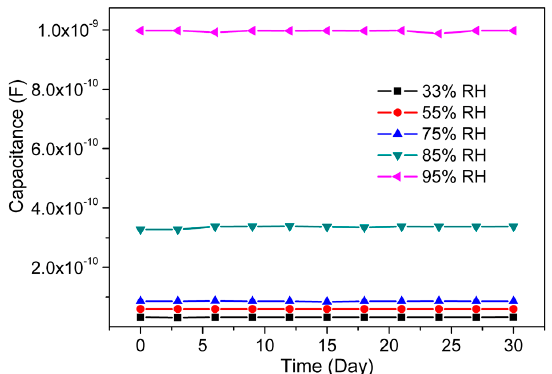
Figure 12. Stability analysis of CMFTO electro-ceramic-based humidity sensor measured at a test frequency 10 2 Hz at 25 ° C. Note: The measurement was conducted repeatedly for 30 days at 2-day interval and very negligible changes are observed.